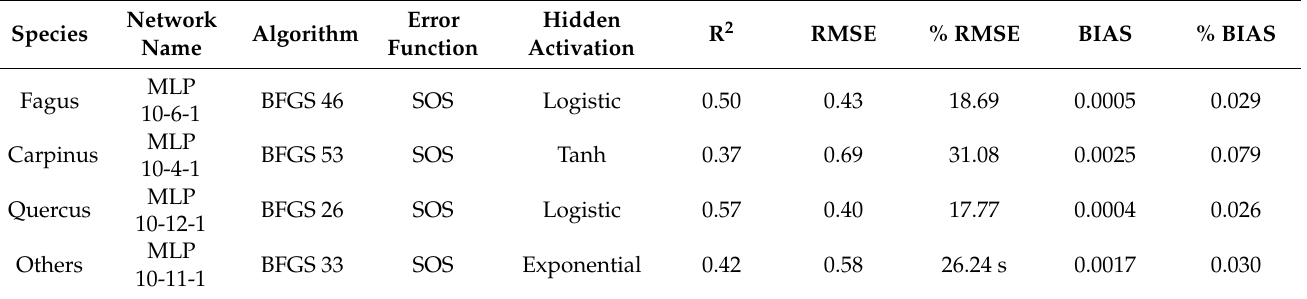
Table 5. The most important characteristics of MLP-based ANNs and associated metrics for diameter model training by species.